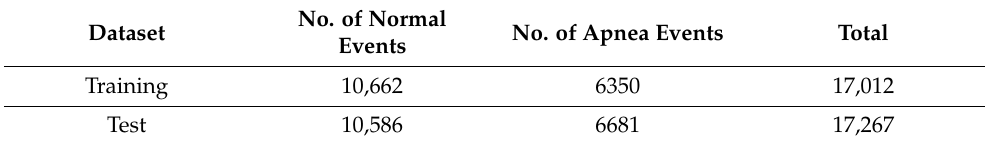
Table 3. Number of normal and apnea events for the subject-independent training and test datasets. Dataset